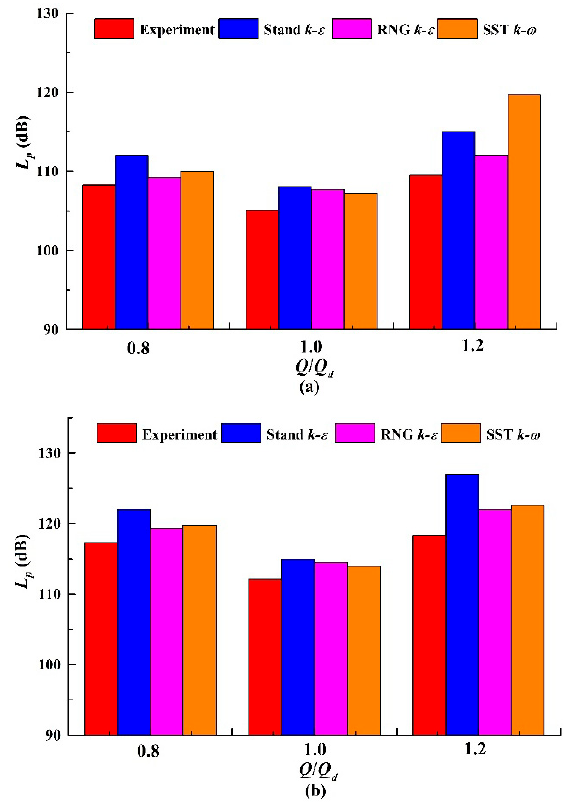
Figure 13. L p at ( a ) suction and ( b ) discharge.